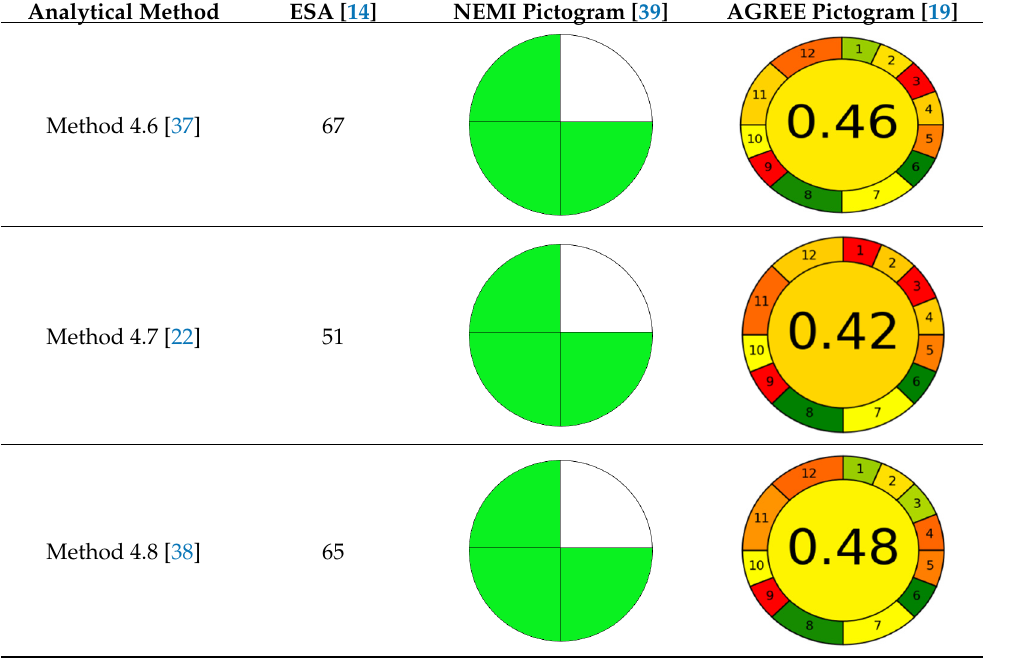
Table 4. Greenness assessment results of methamphetamine and heroin analytical